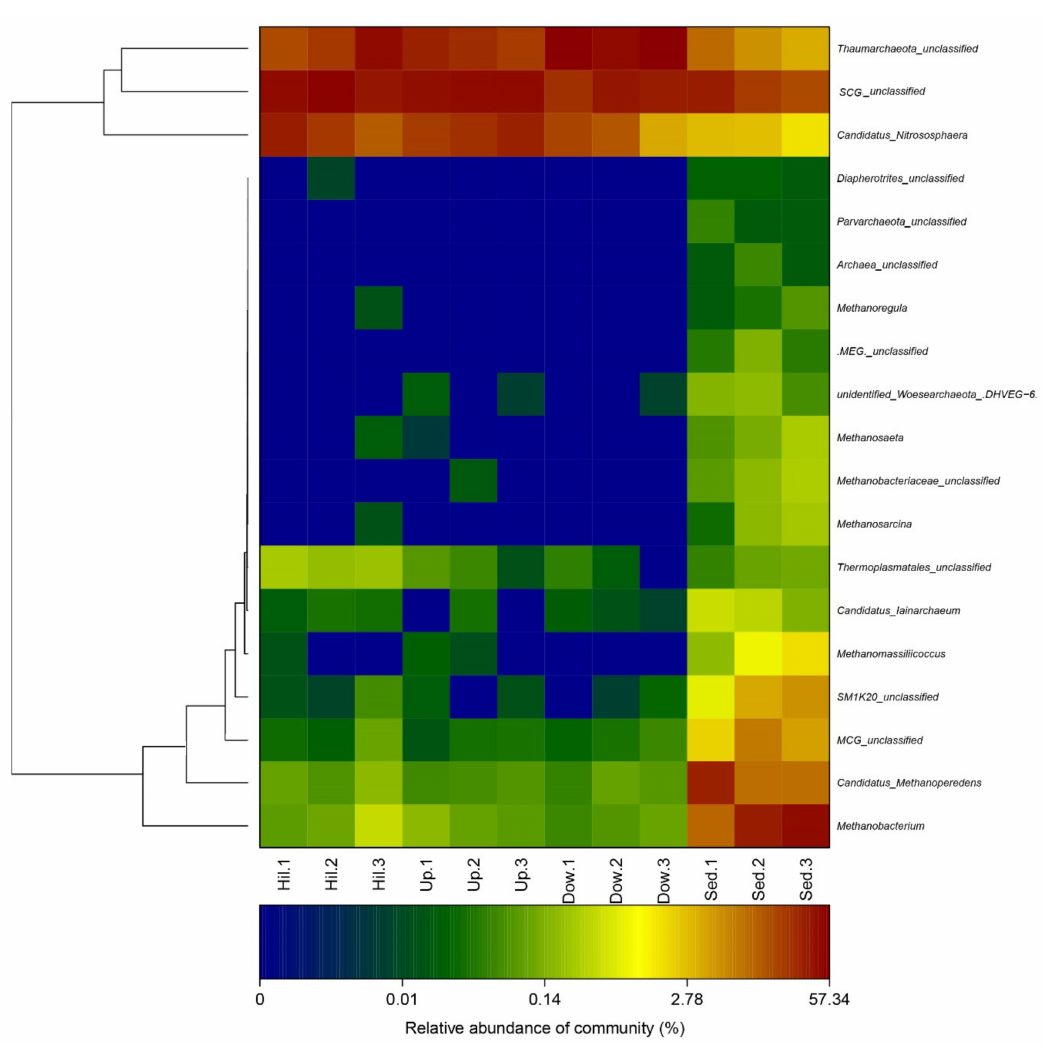
Figure 5. A heat map of the archaeal genus at different sampling sites in the Arctic lake area. A phylogenetic tree is on the left. The changes of the color gradient indicate the richness of the archaeal